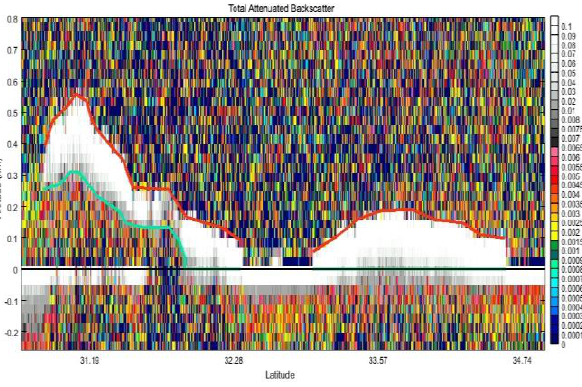
Figure 3. May 13th, 2017 CALIOP 532nm Atmospheric Attenuation Backscattering Coefficient